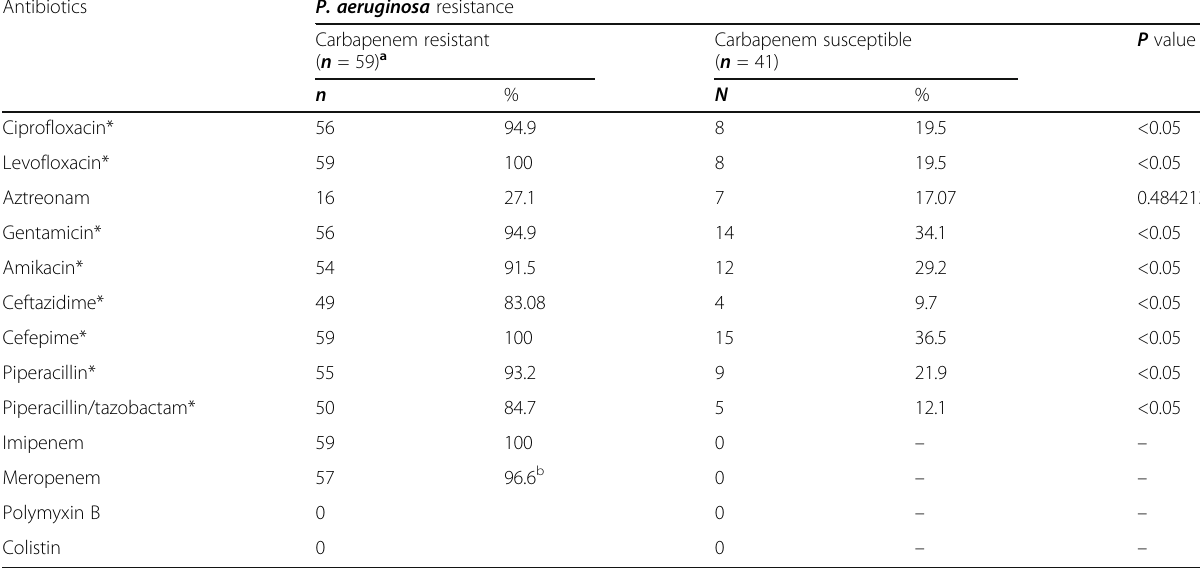
Table 2 Antibiotic resistance profile of carbapenem-resistant versus carbapenem susceptible P. aeruginosa isolates Antibiotics P. aeruginosa